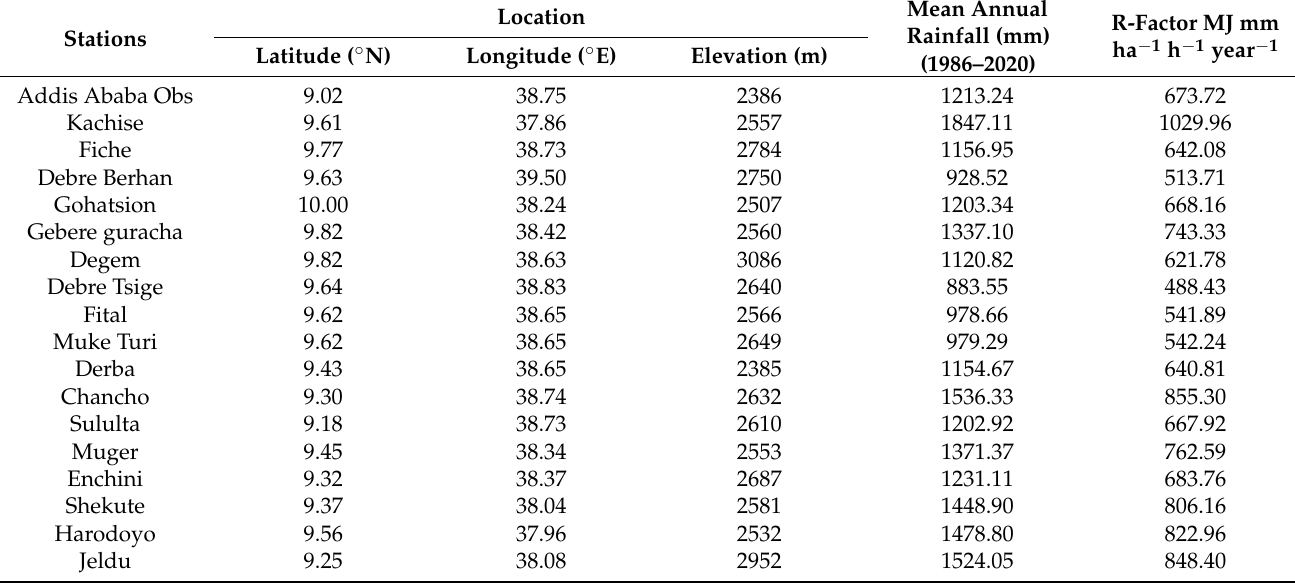
Table 2. The mean annual rainfall (mm) and the